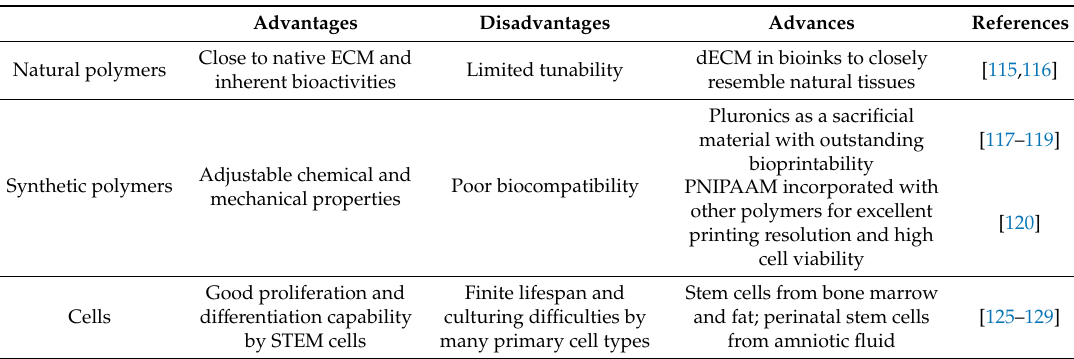
Table 2. Summary of bioprinting